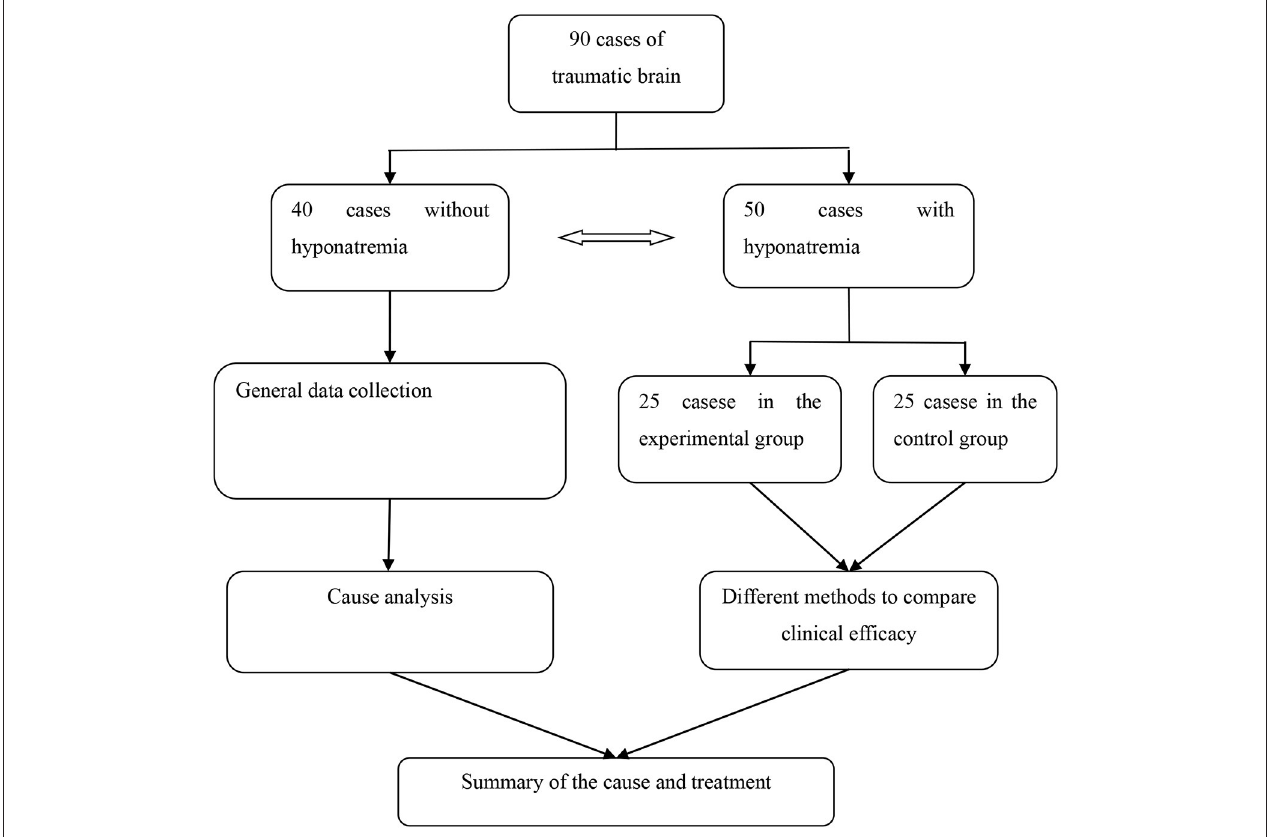
FIGURE 1 | Research flow